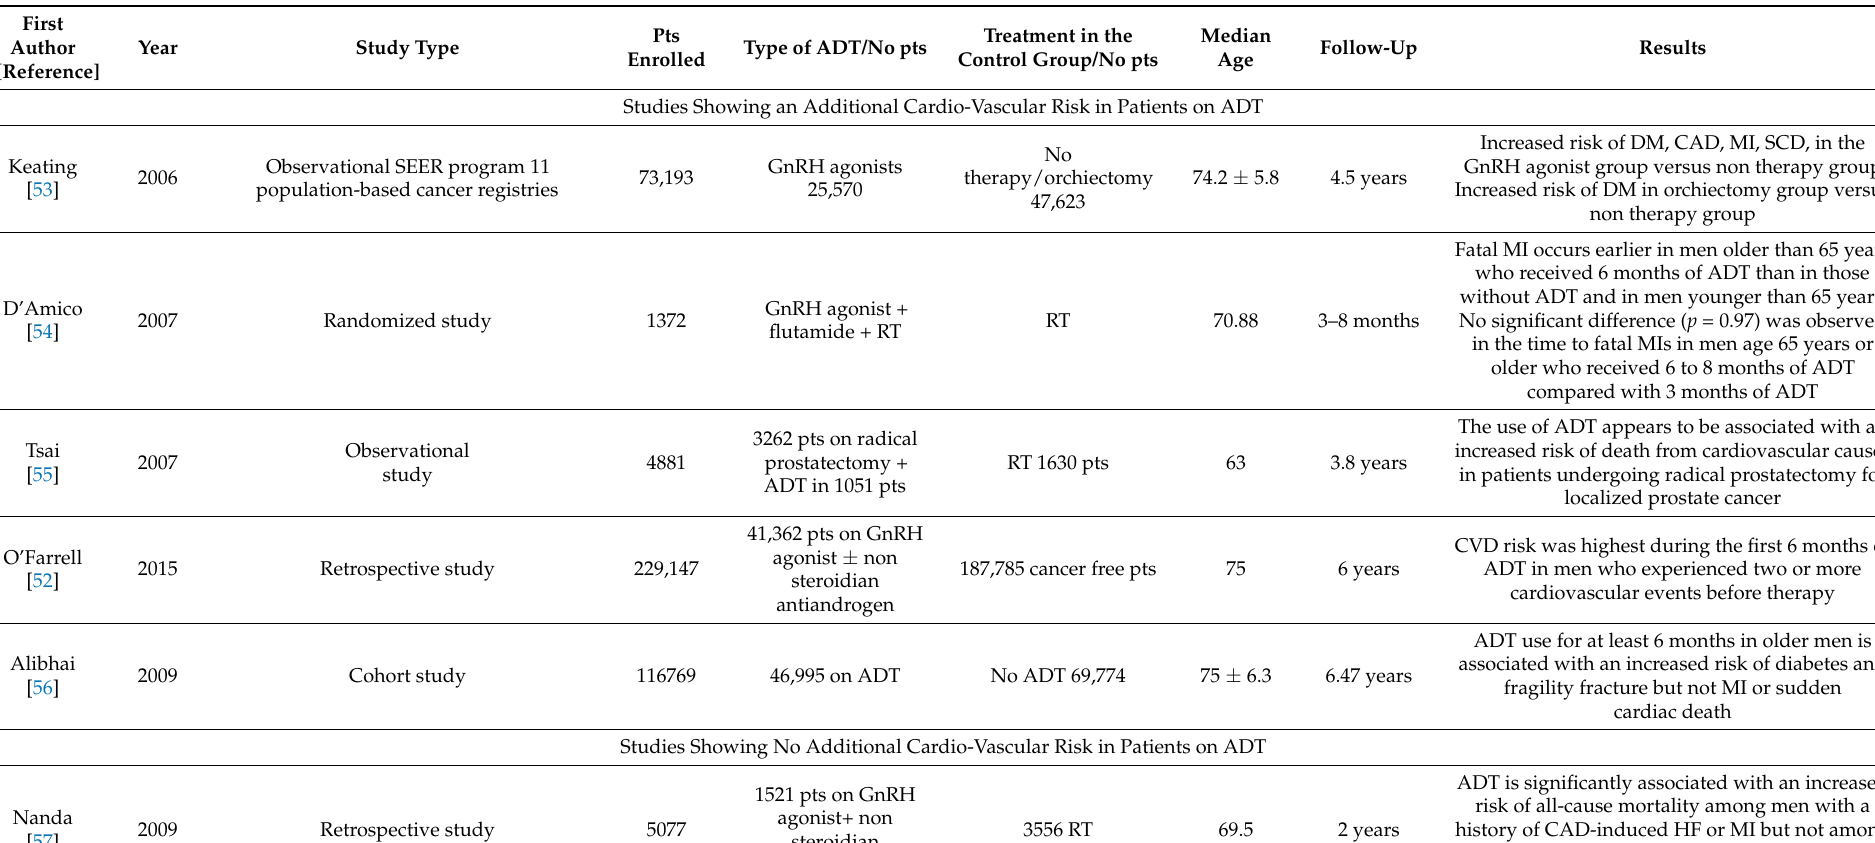
Table 3. Studies regarding the cardio-vascular effects of the androgen deprivation